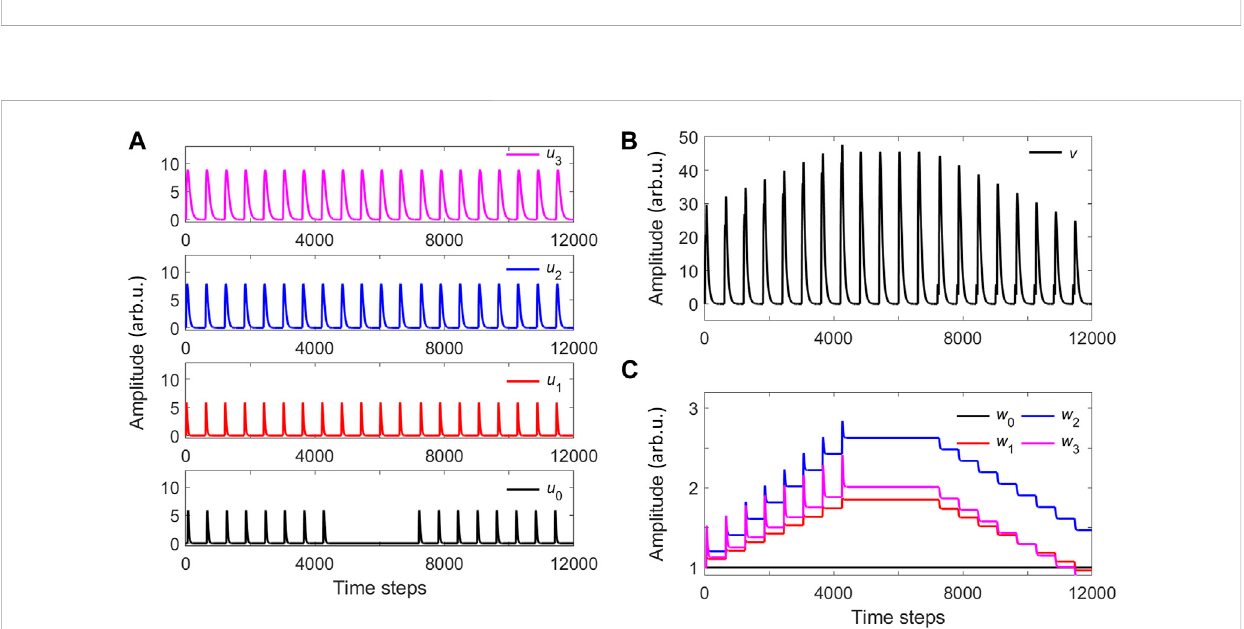
FIGURE 7 Numerical simulations of the ICO rule with one stimulus signal x 1 that feeds three different activation fi lters ( u 1 − u 3 ). (A) Input activation signals (reference and stimuli). (B) Output of the ICO rule. (C) Plastic weights that correspond to the stimuli activation